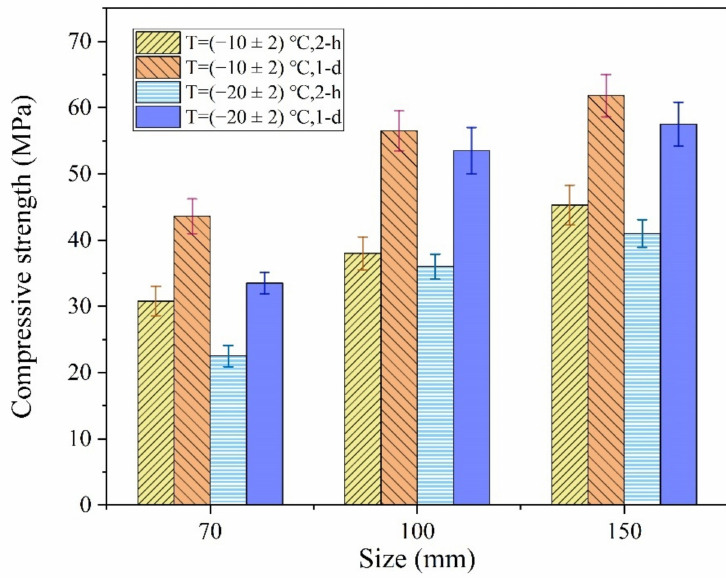
Figure 15. The influences of specimen size on the early strength of the MPCC.